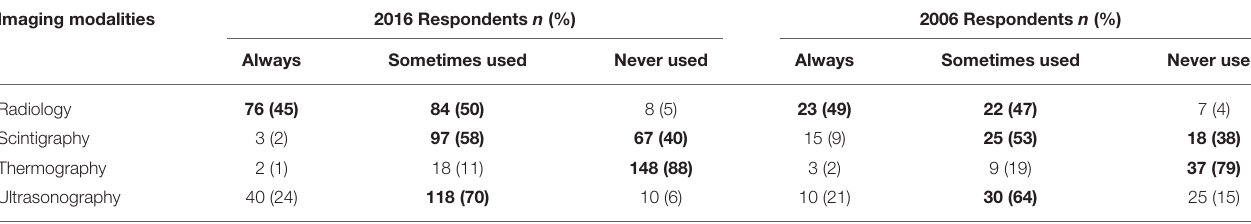
TABLE 4 | Frequencies of imaging modalities used to diagnose spinal pathologies by 2006 and 2016 survey respondents. Imaging modalities